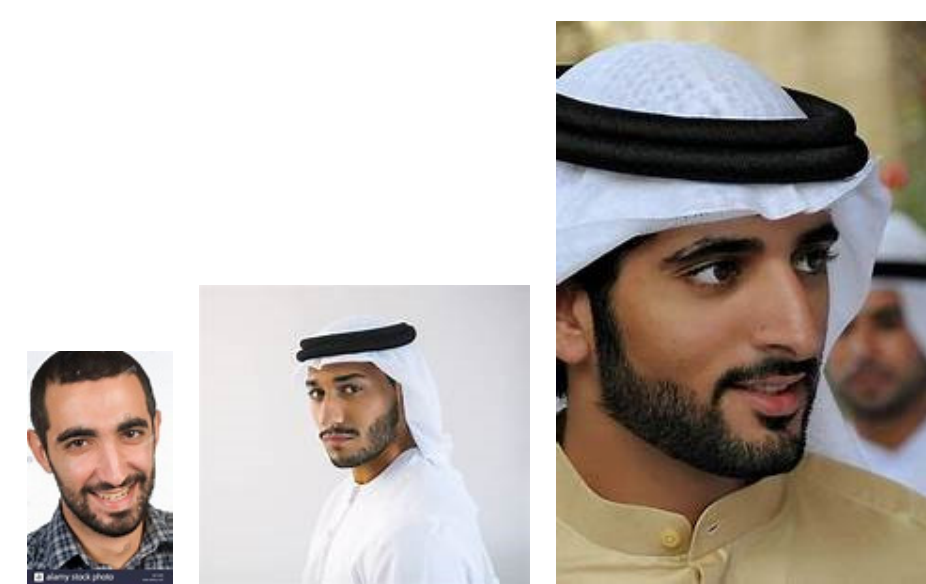
Figure A3. Persons of Middle Eastern Ancestry.